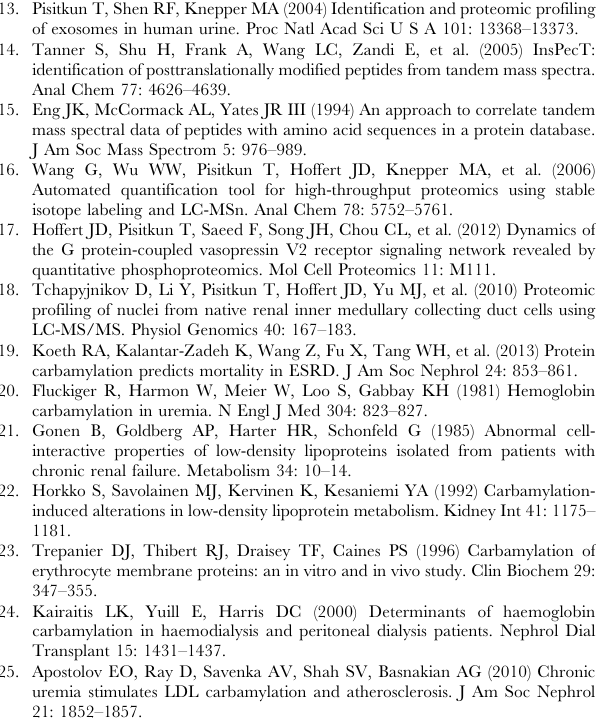
Figure S1 Additional example spectra of carbamylated peptides. Six example spectra showing carbamylation of physiologically important